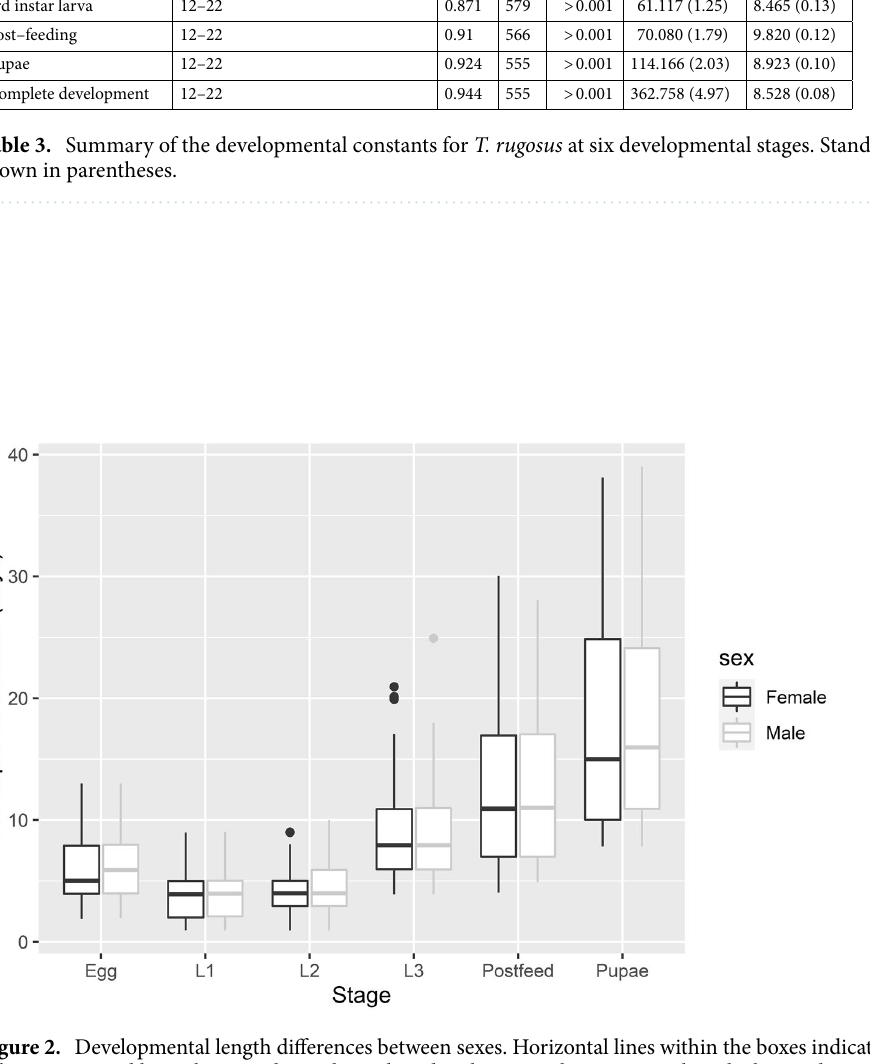
Figure 2. Developmental length differences between sexes. Horizontal lines within the boxes indicate median values; upper and lower boxes indicate the 75th and 25th percentiles, respectively. Whiskers indicate the values within the 1.5 interquartile ranges. Small dots are outliers. Females indicated in clear black boxes and Males in faded gray color